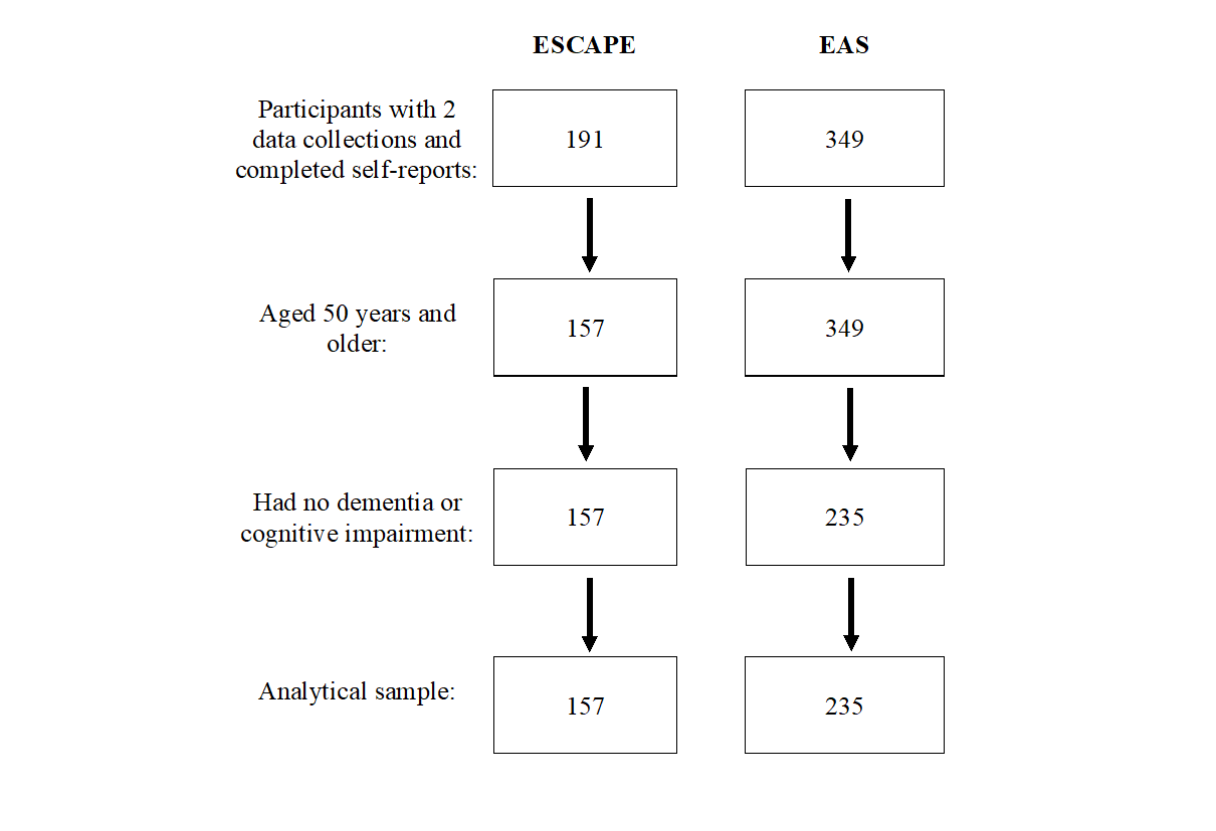
Figure 3. Sample size from the Effects of Stress on Cognitive Aging, Physiology, and Emotion study and Einstein Aging Study based on the inclusion